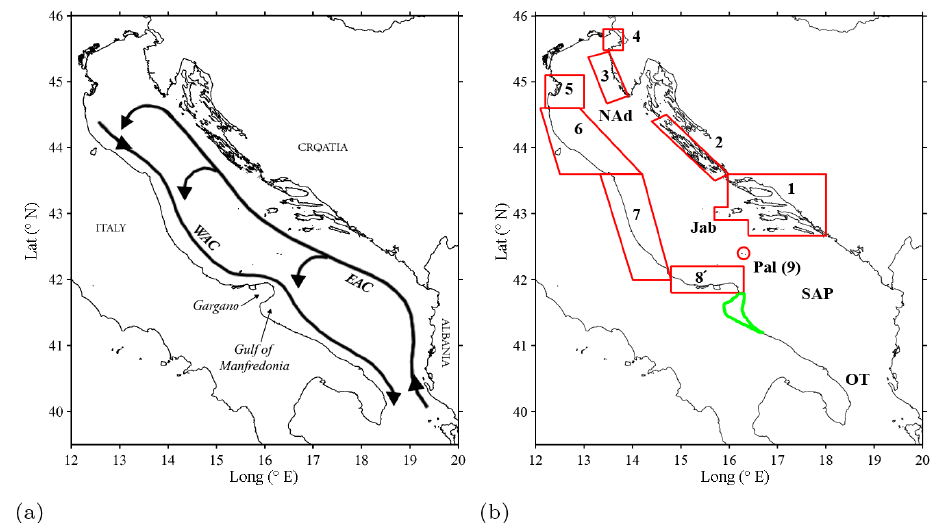
Figure 1. (a) The Adriatic Sea with main circulation branches: Eastern Adriatic Current (EAC), Western Adriatic Current (WAC) and the northern, central, and southern sub-basin gyres (adapted from Poulain and Cushman-Roisin, 2001). (b) The Adriatic Sea with the northern Adriatic (NAD), Jabuka Pit (Jab), southern Adriatic Pit (SAP), and the Strait of Otranto (OT) labeled. The SAs (outlined in red) are (1) the southern Dalmatian Islands, (2) the northern Dalmatian Islands, (3) the Istrian Peninsula, (4) the Gulf of Trieste, (5) the Po River Delta, (6) the northern Italian Adriatic coast, (7) the central Italian Adriatic coast, (8) the northern Gargano Promontory, and (9) Palagruža Islands. The Gulf of Manfredonia nursery area is shown in